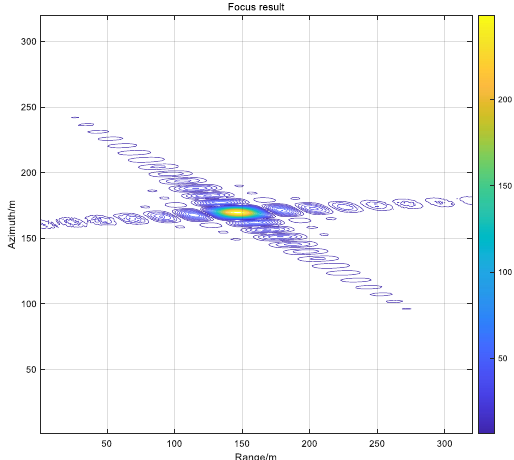
Figure 18. FPGA processing single point results. Table 5. Result of the single point.